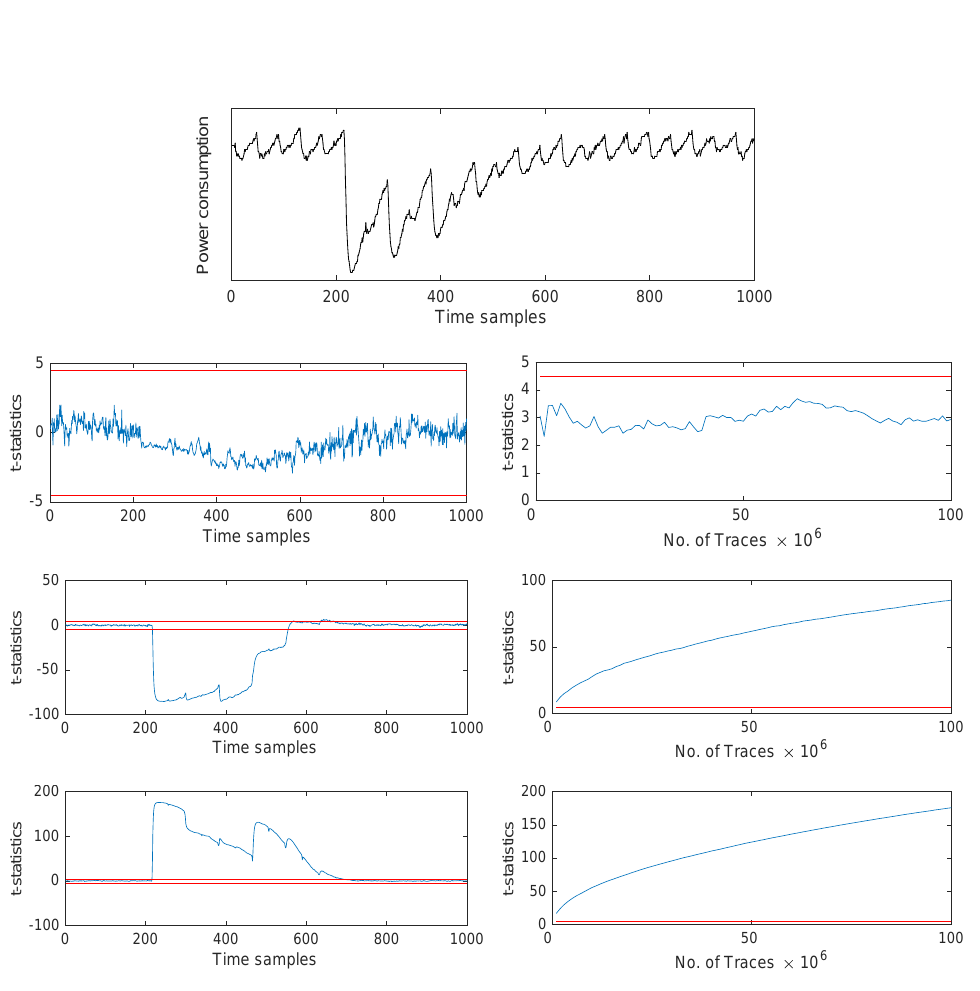
Figure 20: Sample power trace and univariate non-specific t -test results with 100 million measurements for two composed UMA multiplications ( d = 2) based on GF (2 4 ) multipliers with only the mandatory registers applied. The second to fourth row show the t -statistics for the statistical moments 1 to 3, respectively, arranged like